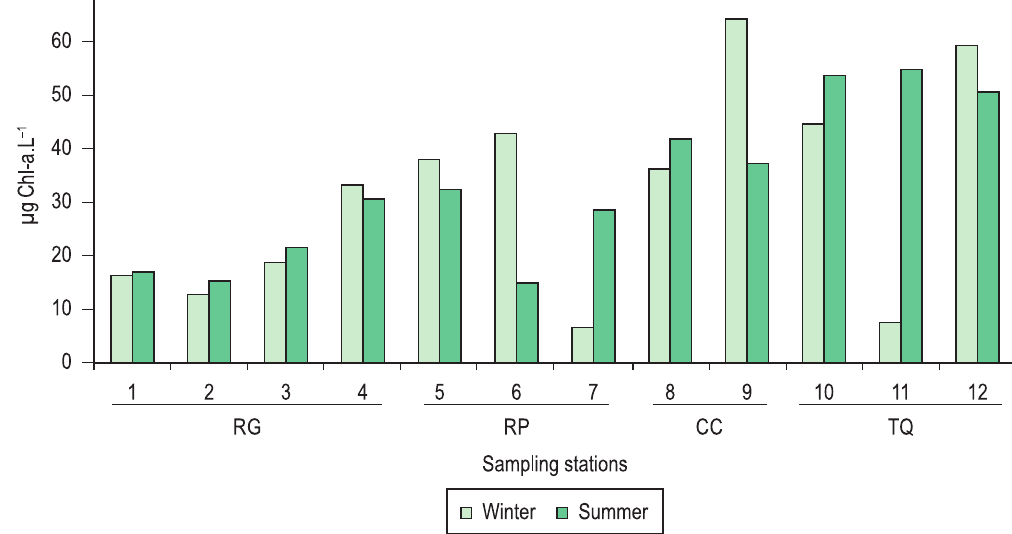
Figure 3. Chorophyll-a concentrations at the water surface in the Billings Complex during winter and summer periods. Sampling sites: RG: Rio Grande Reservoir, RP: Rio Pequeno branch, CB: Central body, TQ: Taquacetuba